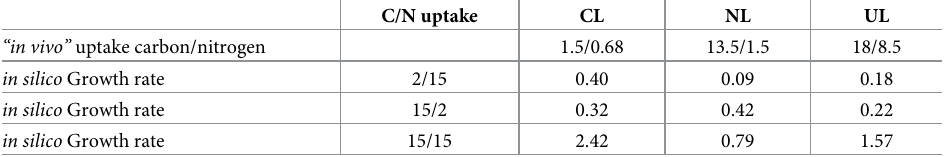
Table 1. The artificial BOFs used in this model. CL is the carbon limited biomass, NL nitrogen limitation, and UL is the unlimited environment. The assumed maximum uptake flux rates are detailed for the respective environments. The growth rates are given in units of h − 1 , while the flux bound on the uptake rates are given in mmol gCDW − 1 h − 1